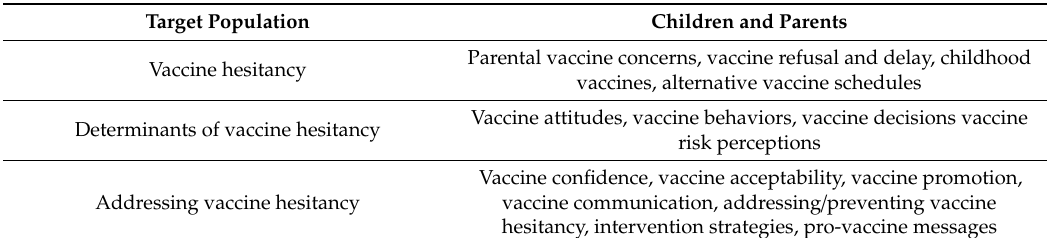
Table 3. Table of search terms